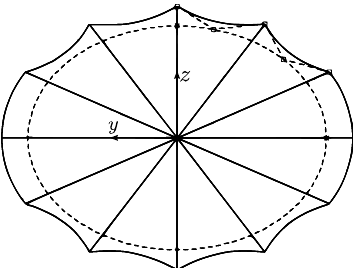
Figure 6. Cross-section of the parametric